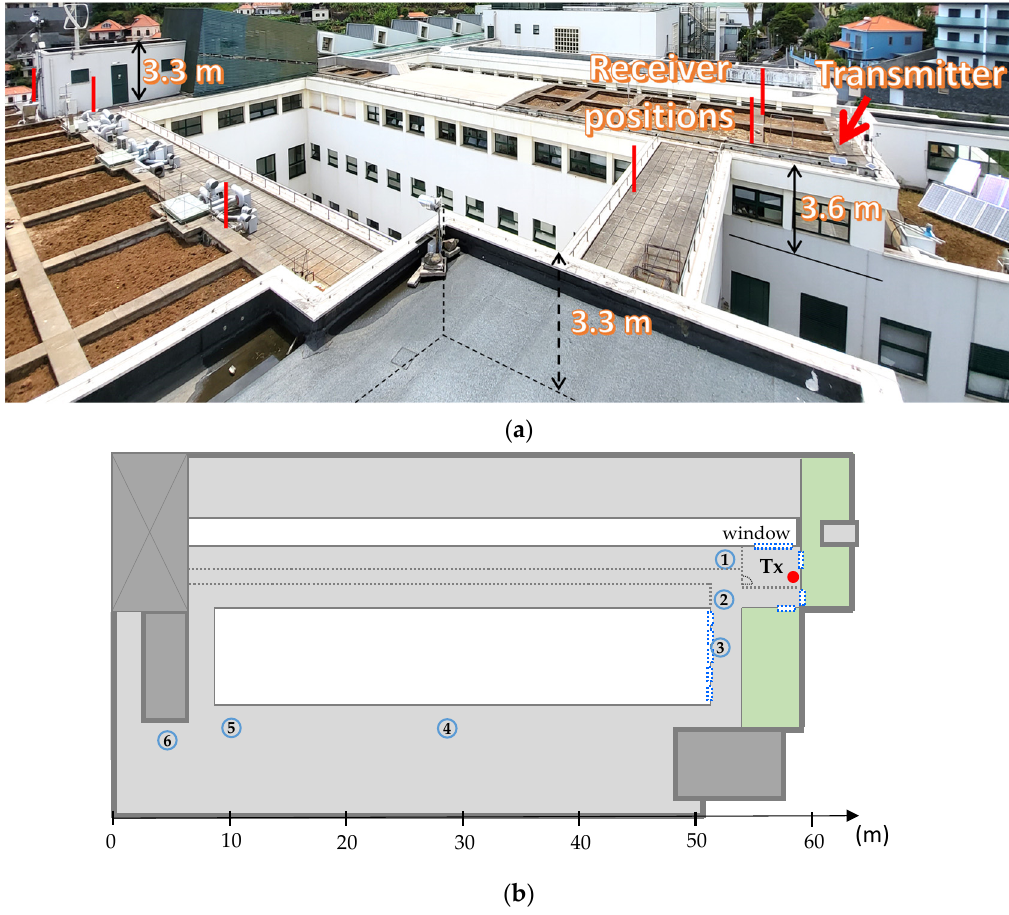
Figure 1. Location 1—terrace of the University of Madeira: ( a ) image of the location; ( b ) plan with the transmitter and receiver positions.